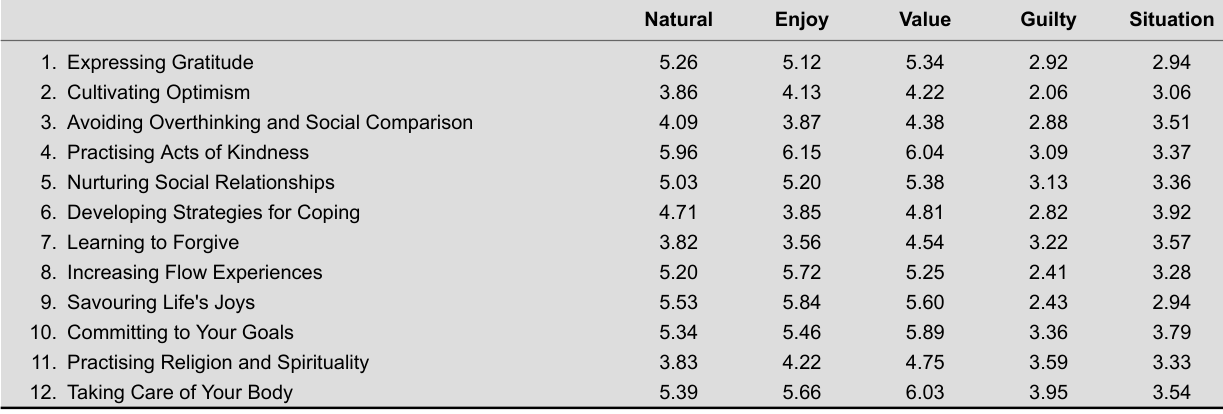
Sample Means of Five Possible Reasons for Choosing 12 Happiness Activities (1 = not at all, 7 = very